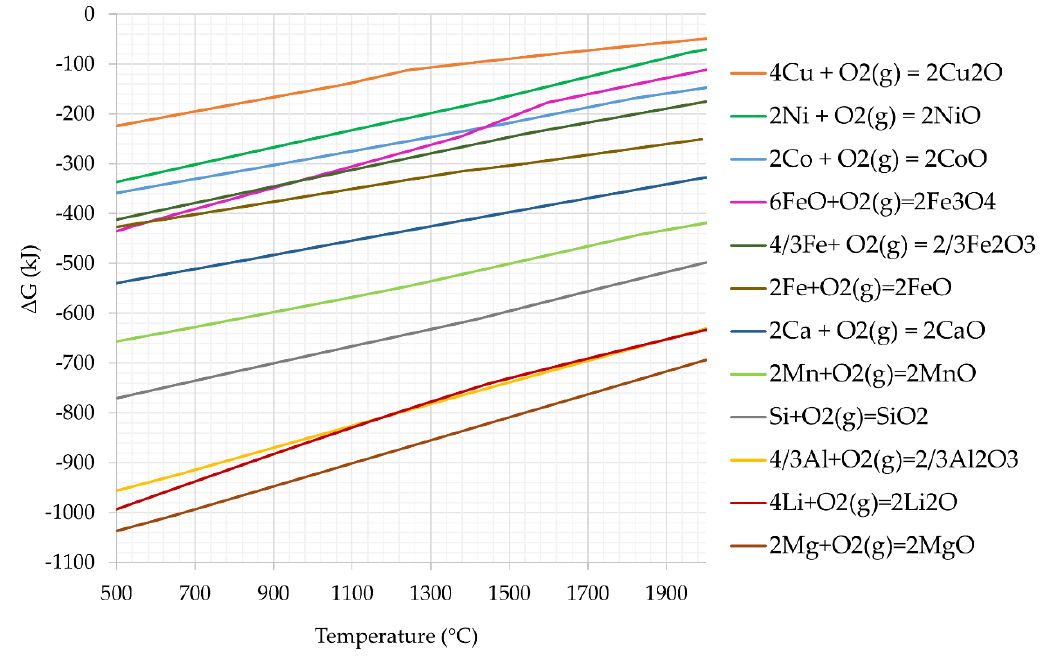
Figure 9. Ellingham diagram drawn with HSC Chemistry 9.0.